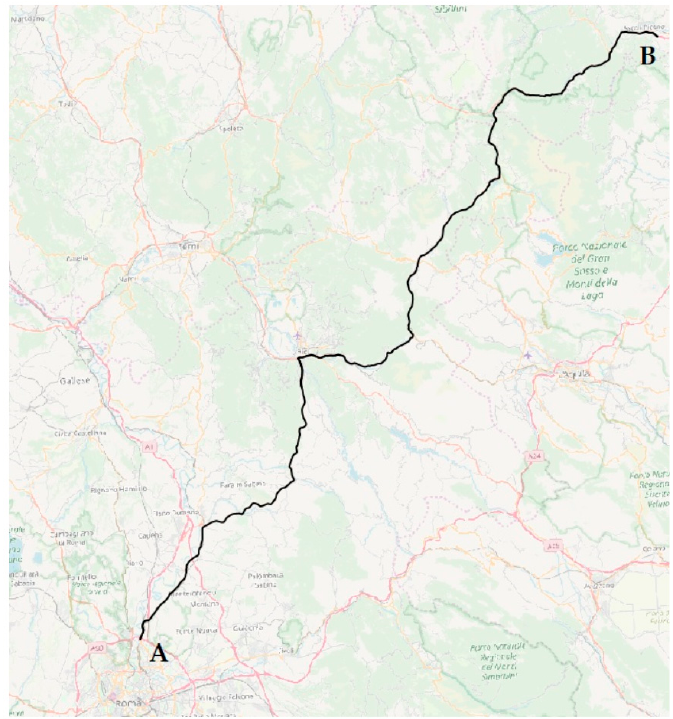
Figure 5. Graph of the HWY 4 from A to B.